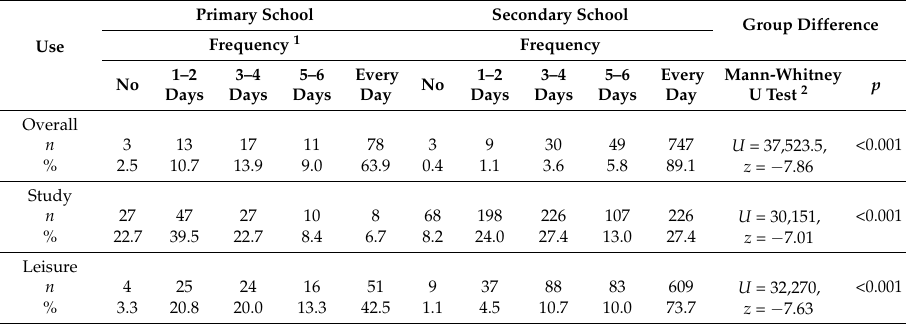
Table 3. Differences in frequencies of smart device activities, overall use and its purposes between primary and secondary school